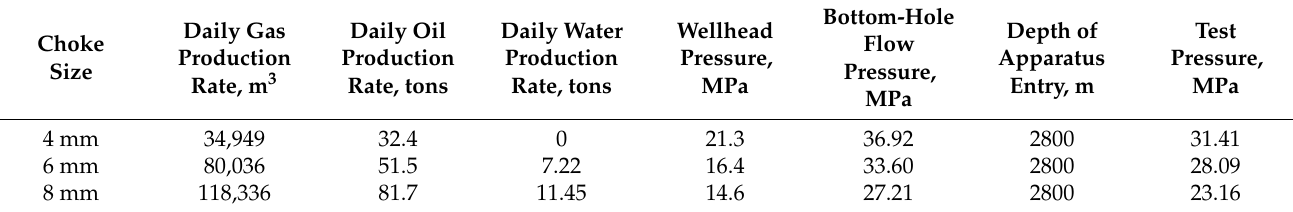
Table 2. Reservoir test data of a condensate gas well in Shengli Oilfield.